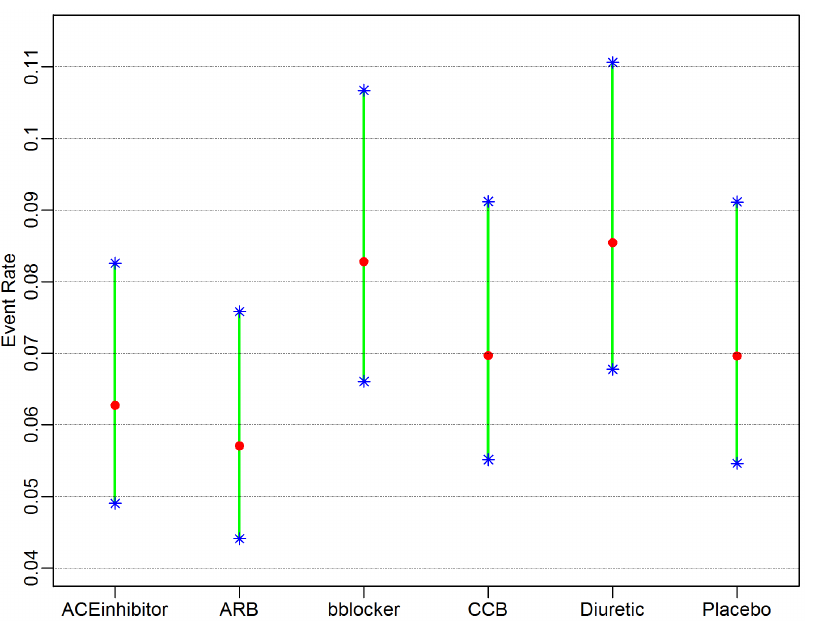
Fig. 6. A confidence interval plot from the pcnetmeta R package displaying estimates of the event rates for all treatments in the diabetes dataset.